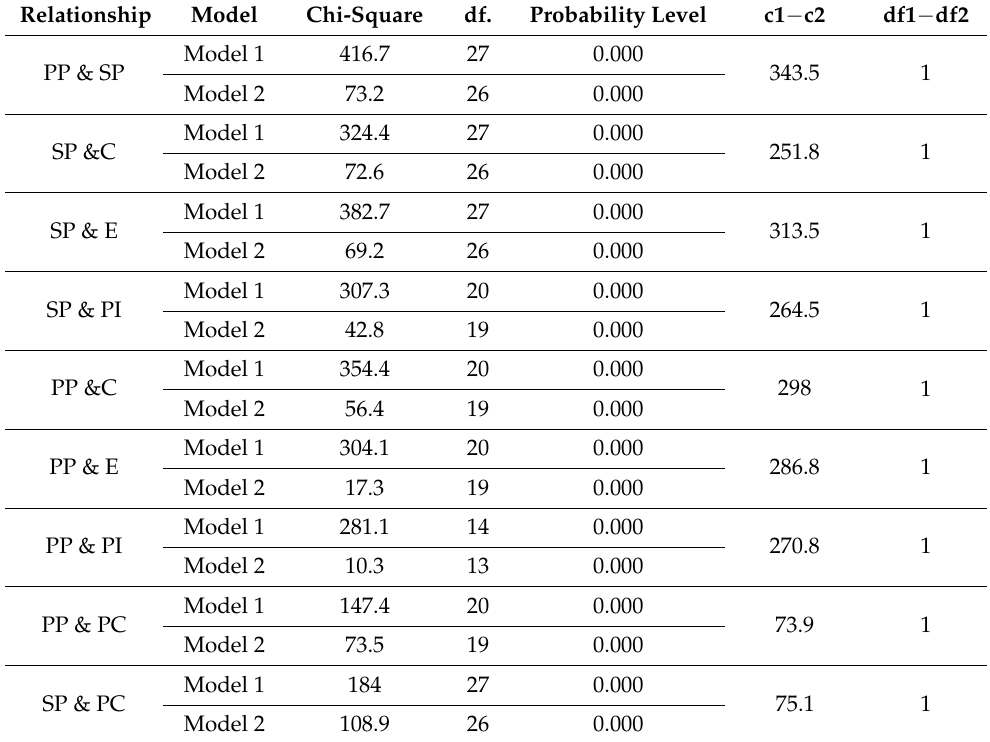
Table 6. Discriminant validity